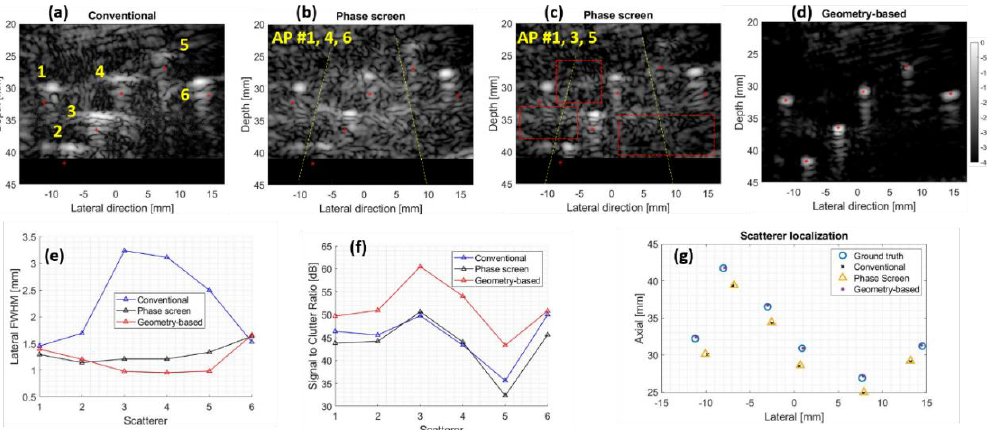
Figure 8. The reconstructed experimental images using the ( a ) conventional beamforming, ( b , c ) phase-screen modeling, and ( d ) geometry-based reconstruction techniques when a Sawbones plate was used in front of the probe as an aberrator. The aberration profiles (AP) of scatterer 4/6 and 3/5 were used in ( b , c ), respectively. The lateral FWHM ( e ), the signal-to-clutter ratio ( f ), and the localization error ( g ) obtained with all the methods for each scatterer. The red dashed boxes were used for signal-to-clutter ratio calculation in Table 1. The red dots indicate the true location of the scatterers. The numbers in ( a ) are used for referencing in the text and ( e – g ).